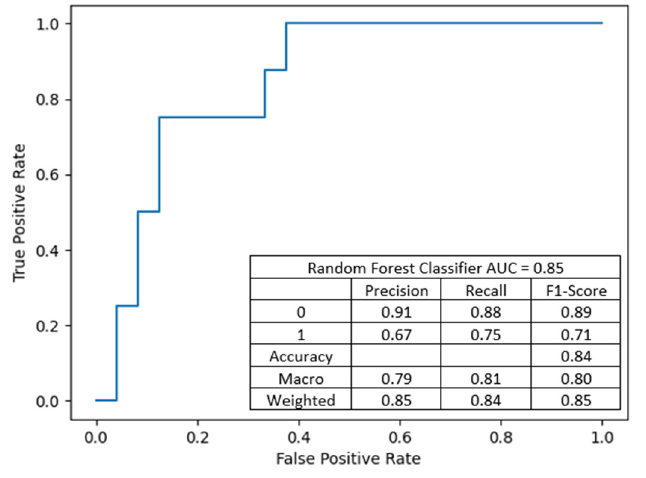
Figure 10. This classifier has a lower discriminant power but better DGF prediction sensitivity than the previous model.